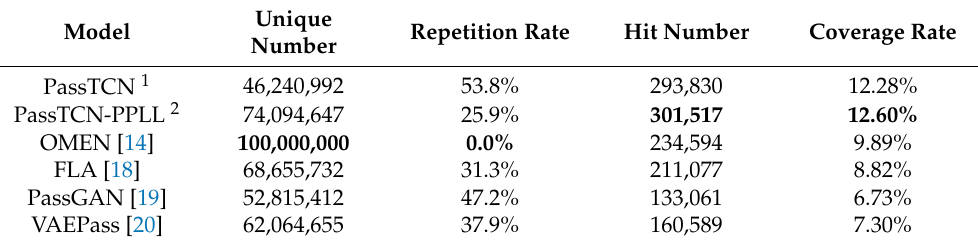
Table 5. The repetition rate and the coverage rate of each model when sampled 10 8 passwords.